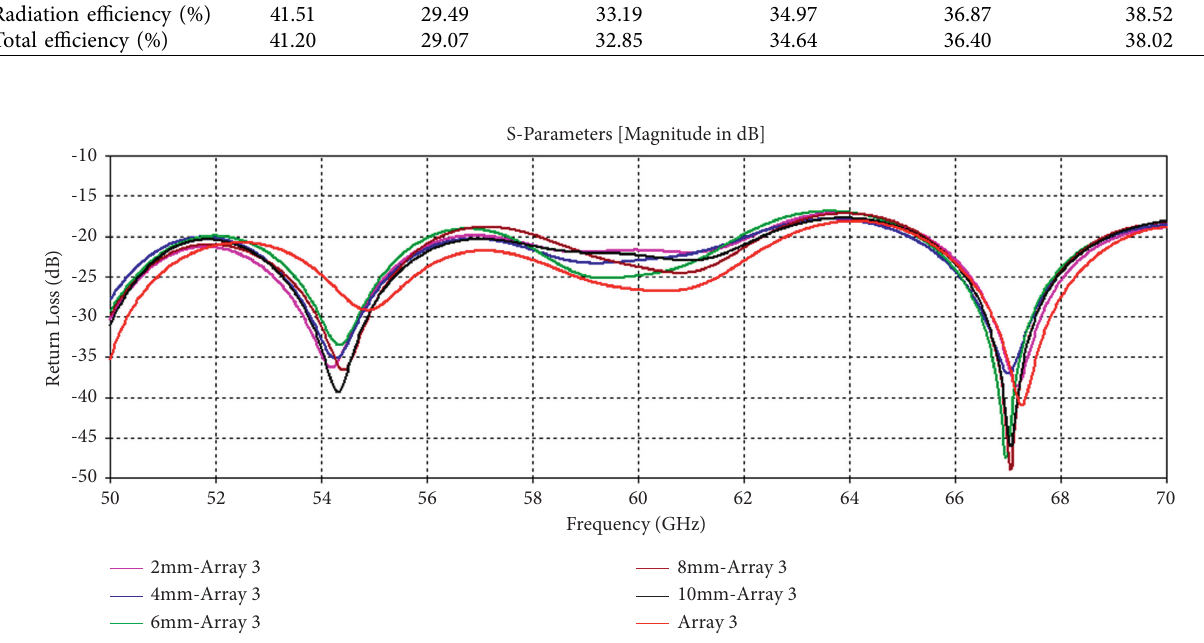
Figure 25: Simulated Array 3 on-body return loss at different distances compared to free space.